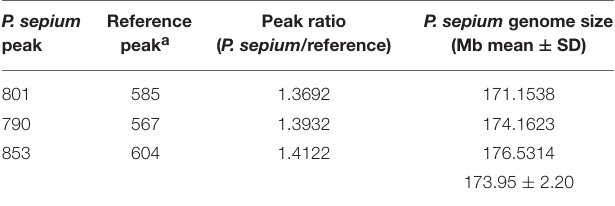
TABLE 1 | Flow cytometry determination of the nuclear genome size of Periploca sepium